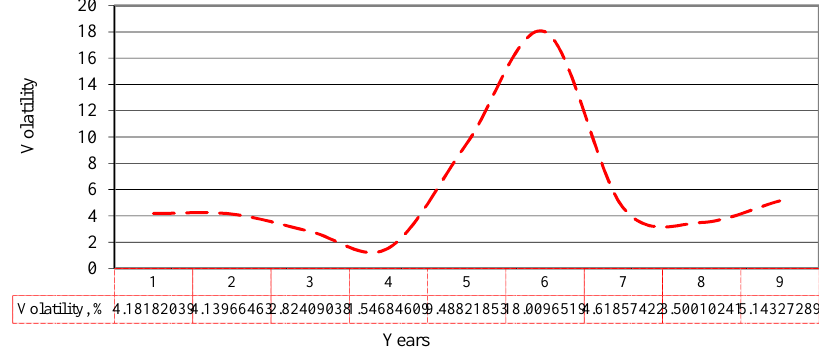
Note: LNDG – ln (D), LNINC – ln (INC), and LNP – ln (P)) Figure 2. Price volatility (%) for the period 2010–2018 by year (each period